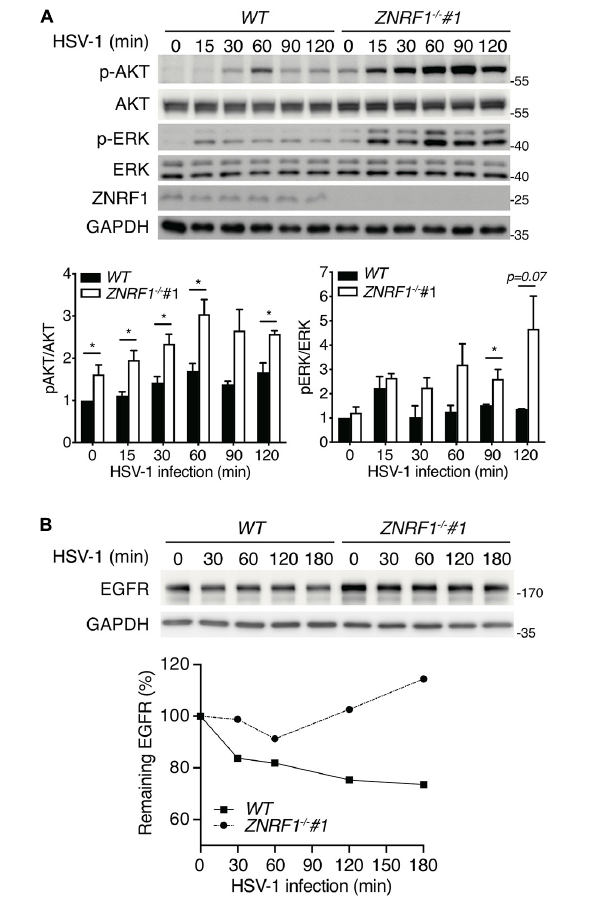
FIGURE 8 | ZNRF1 depletion enhances EGFR signaling after HSV-1 infection. (A) Wild type (WT) and ZNRF1 − / − A549 cells were infected with HSV-1 (MOI = 10) for the indicated times. Activation of AKT and ERK was detected by immunoblotting. Quantification of immunoblotting analysis data of three independent experiments are shown in the lower panel. * P < 0.05 (Student’s t -test). (B) Wild type and ZNRF1 − / − A549 cells were serum-starved overnight and infected with HSV-1 (MOI = 15) for the indicated times. The protein levels of EGFR were detected by immunoblotting, quantified, and compared to untreated cells after normalization to GAPDH level. Quantification of EGFR level is shown in the lower panel. The data are representative of three independent